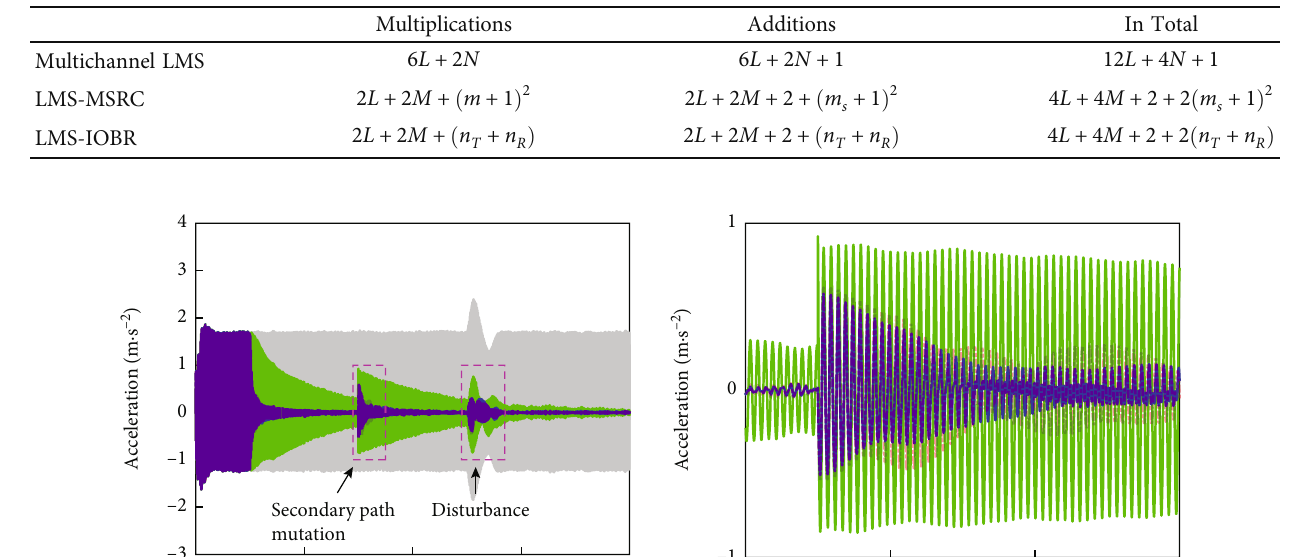
Table 2: Computational complexity.